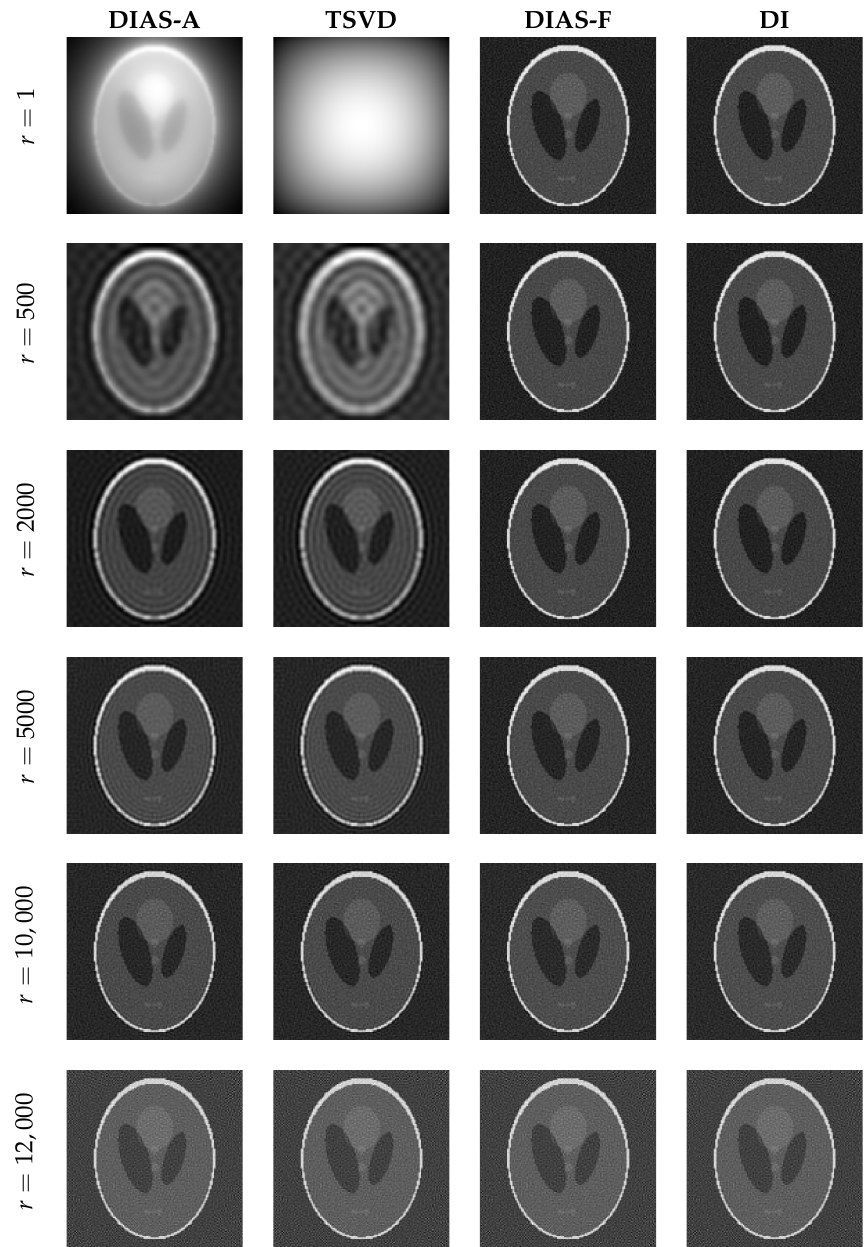
Figure 14. DIAS solutions for X-ray tomography problem with optimal regularization parameter α optimal = 1.3 × 10 5 , noise level